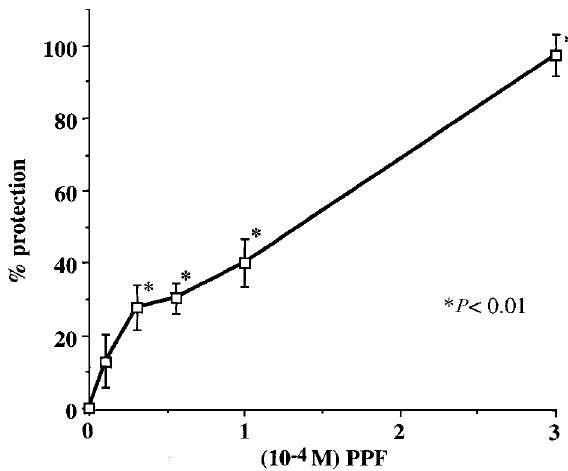
FIG. 5. Dose-dependent protection (±SD) of endothelial cells by Diprivan® against oxidant stress ( n